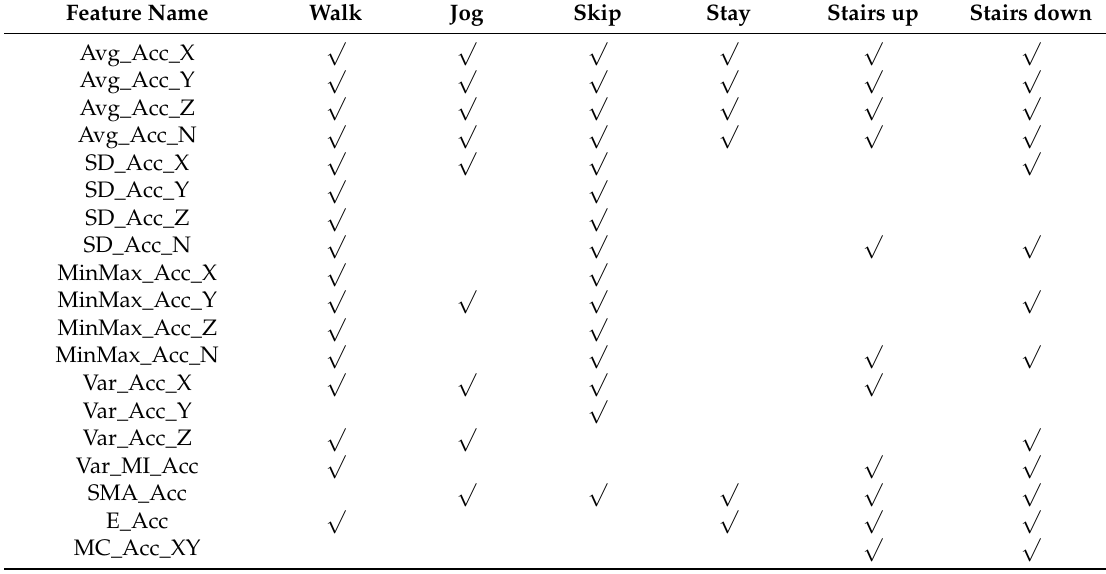
Table A3. List of selected features due to the different activity datasets in the accelerometer and gyroscope